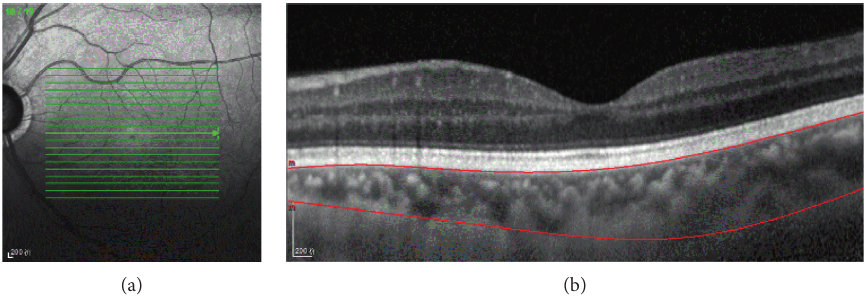
Figure 2: Optical coherence tomographic image (enhanced depth imaging mode) for measurement of the macular choroidal